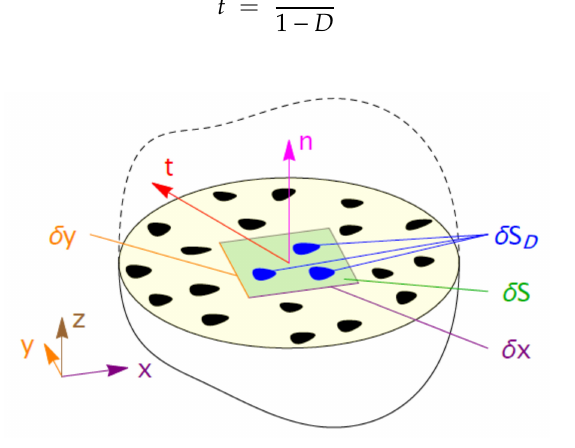
Figure 2. Damage of an interface